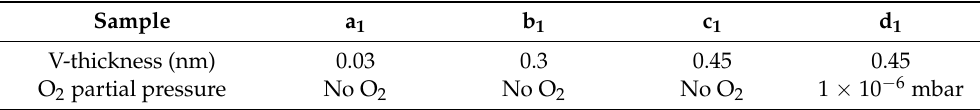
Table 1. Deposition parameters of the as-grown V or VO x films prepared under different conditions. V-thickness is calculated from the deposition rate (0.001 nm/s; calibrated via a QCM) and the deposition